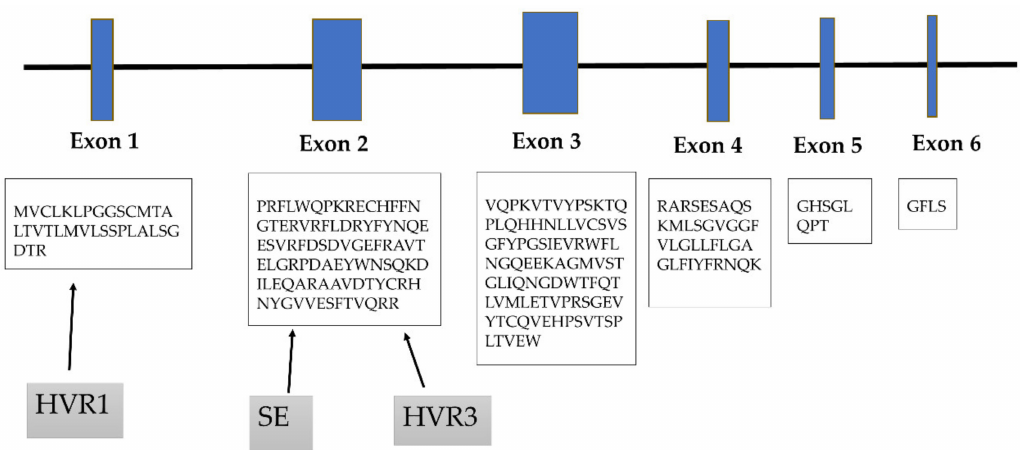
Figure 4. HLA-DRB1 gene is encoded by six exons. Exon 1 encodes the leader peptide, Exons 2 and 3 encode the two extracellular domains, Exon 4 encodes the transmembrane domain, and Exon 5 encodes the cytoplasmic tail. Amino acid motifs forming the first hypervariable region (HVR1) are encoded by Exon 1, the major HVR3, and shared epitope motifs are encoded by Exon